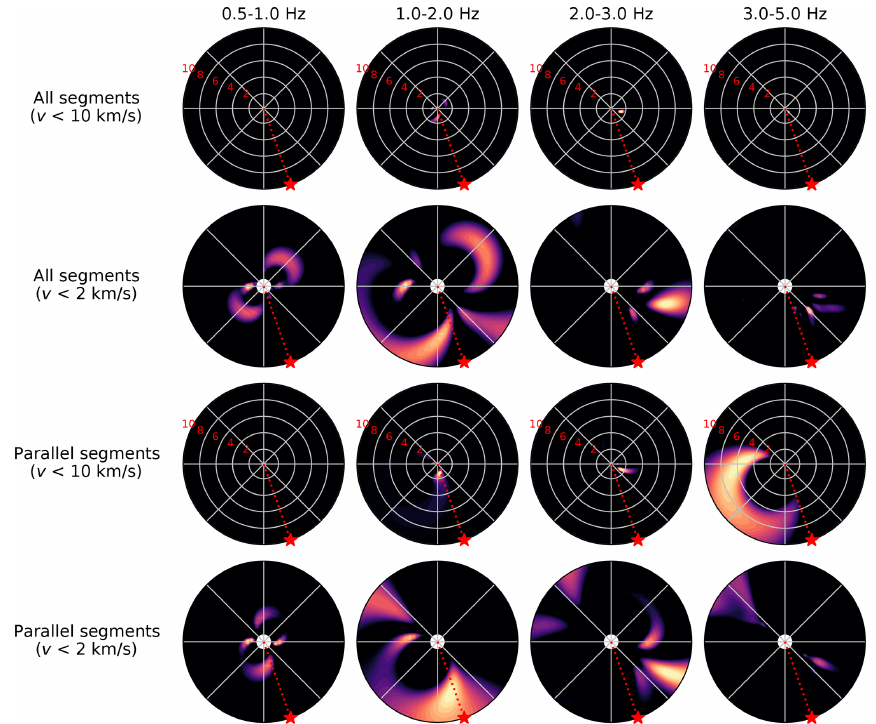
Figure 9. Beamforming results of the P waveforms recorded by the virtual DAS array, derived from the E and N components of the nodal seismometers (i.e. Eq. 4). The panel representation is the same as in Fig. 4. Each second row of panels is a magnification of the upper row, highlighting the sources with low apparent phase velocity ( < 2kms − 1 ). The upper two rows are the results of beamforming all the segments, while the lower rows are the results of beamforming only sub-parallel segments (indicated in red in Fig. 8a).